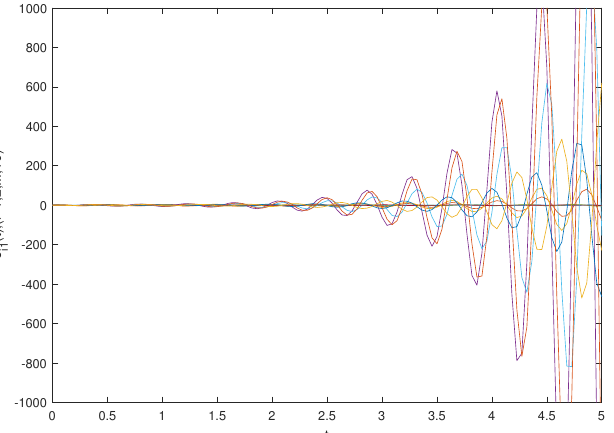
Figure 1. Synchronization errors e i 1 ( i = 1,2, · · · ,10 ) of the fractional-order system (32) and (33) without the